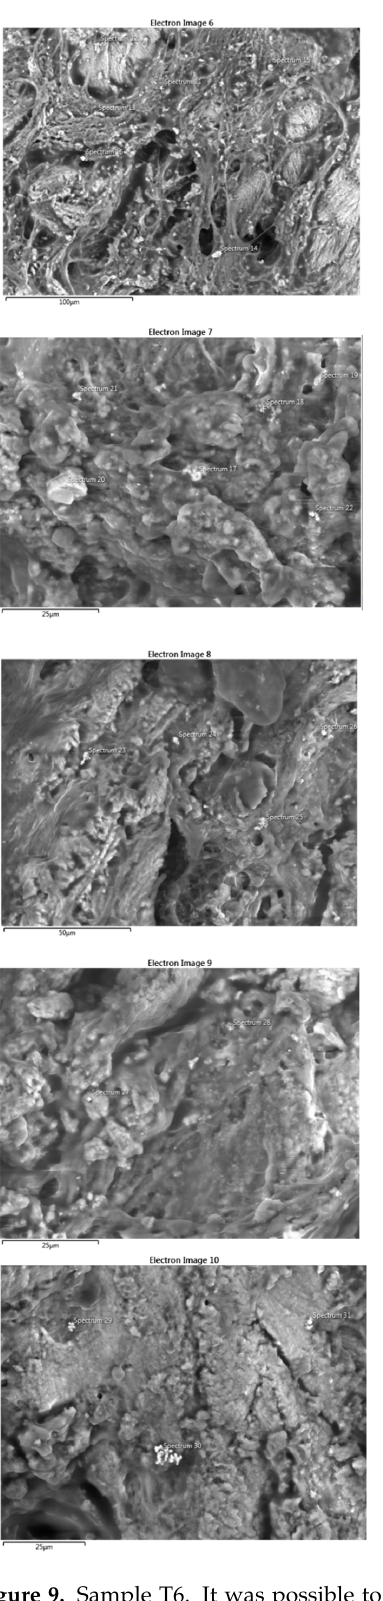
Figure 9. Sample T6. It was possible to spot up to five fields, showing the presence of particles that were morphologically reactive. The microanalysis showed the presence of titanium, iron, and siliceous. Spectra outputs were realized using GrapPad Prism